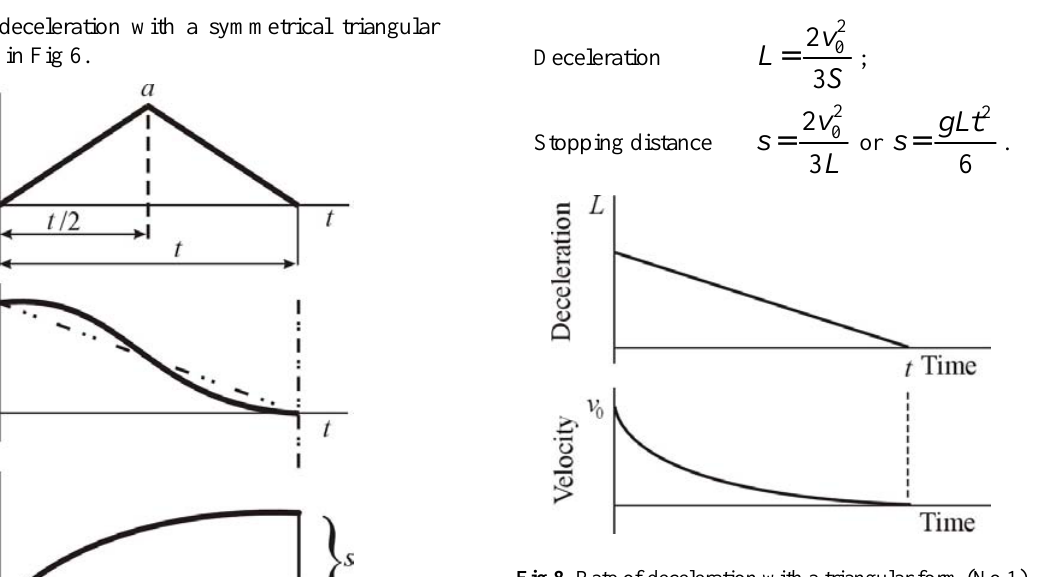
Fig 8. Rate of deceleration with a triangular form (No 1) When the rate of deceleration is triangular form No 2 (Fig 9):